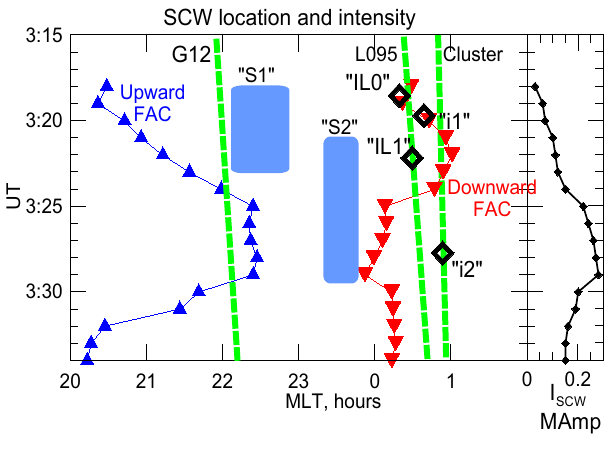
Fig. 5. MLT locations of the SCW upward and downward field- aligned current (left) and SCW intensity in MAmps (right) obtained from analysing midlatitude perturbations. MLT locations of geo- stationary G12, L095 and Cluster spacecraft (mapped at 7–12 R E equatorial) are presented by green lines. Locations of auroral pole- ward boundary intensifications are shown by light-blue bars. The onset times of electron injections observed by L095 and Cluster are shown by black diamonds.